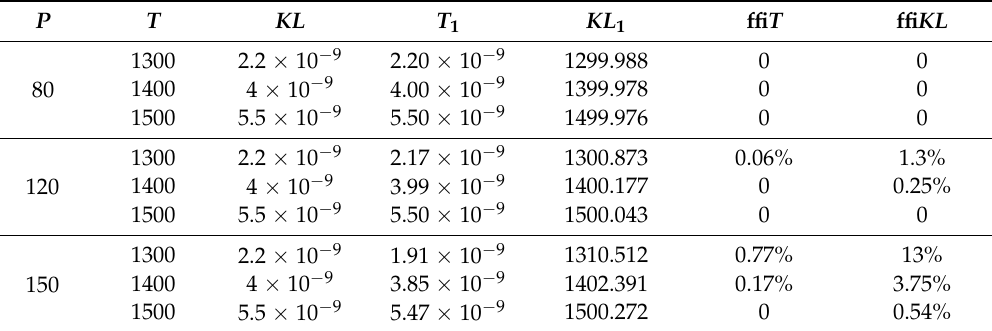
Table 1. Predicted and calculated values with different types of white noise.